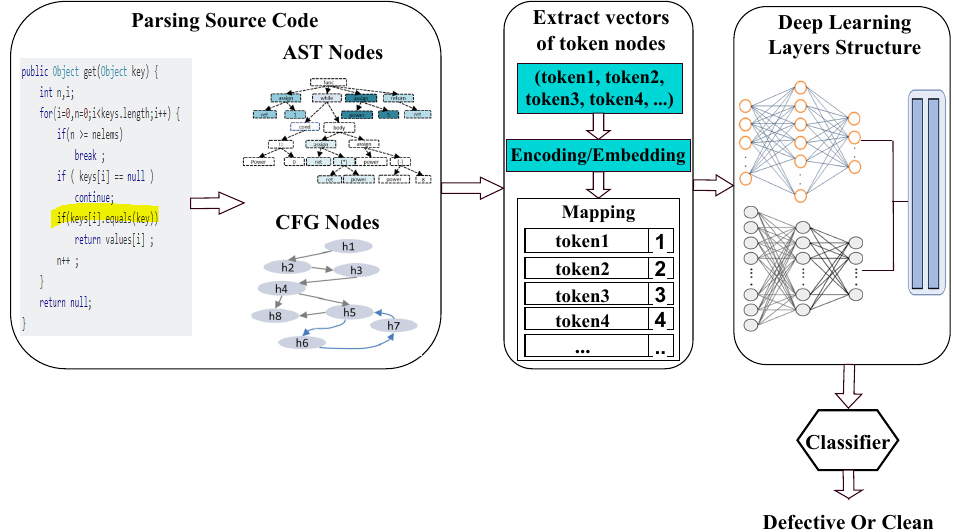
Figure 3. Software defect prediction based on source code semantic